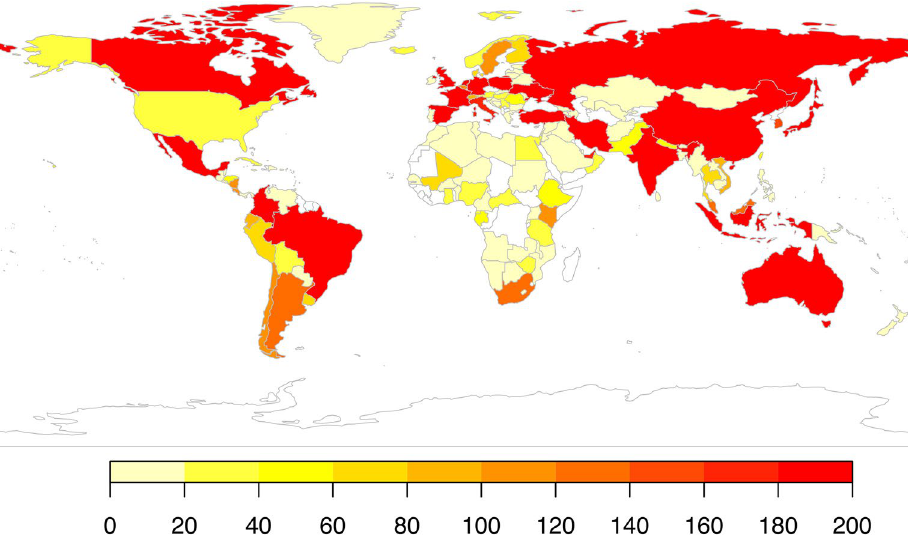
Figure 6. Geographical distribution based on country-code TLD. Countries colored in red contain TLDs with more than 180 URLs; orange shades are between 60 and 180; yellow are between 1 and 60. This map was created in R, version 4.1.2 (2021–11-01), link: https:// cran.r- proje ct. org/.